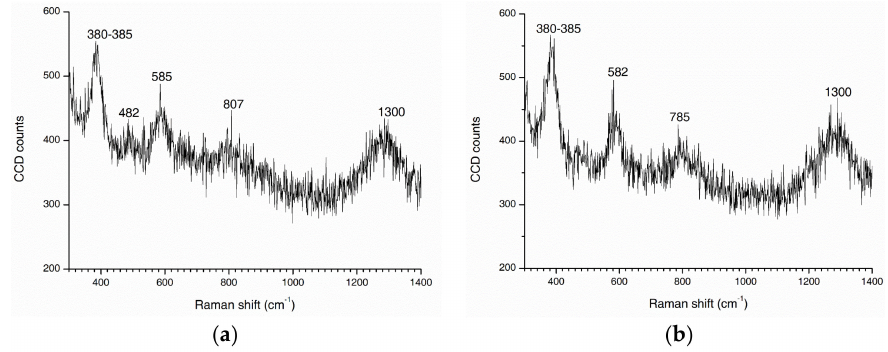
Figure 12. Raman spectra of rust samples in ( a ) The atmospheric zone and ( b ) The tidal